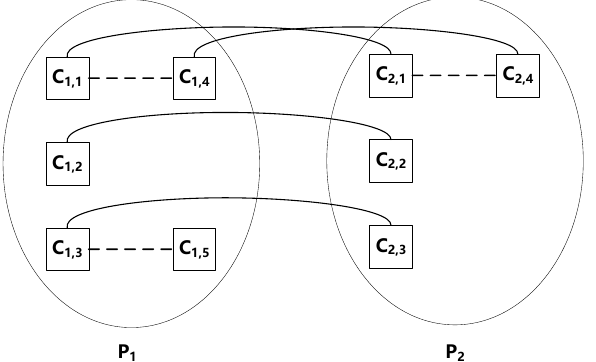
Figure 2. Illustration of TCG of two versions of a program, denoted by P 1 and P 2 . The boxes represent code fragments, the dashed edges represent the clone relations between code fragments in a single version of the program (i.e., P 1 or P 2 ), and the solid edges represent the clone relations between code fragments in different versions of the program (i.e., between P 1 and P 2